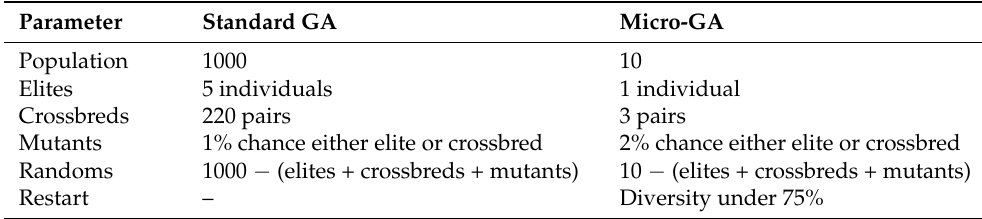
Table 2. Configurable parameters of genetic and micro-genetic algorithms. Parameter Standard GA Micro-GA Population 1000 Elites Crossbreds Mutants Randoms Restart –